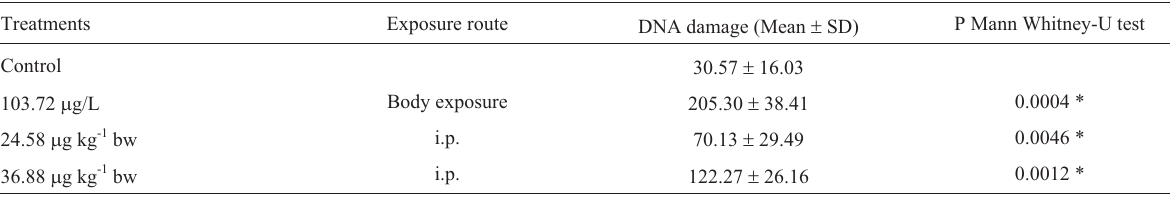
Table 2 - Means (SD) of DNA damage index obtained from comet assay from peripheral erythrocytes of Astyanax bimaculatus after treatment with ex- tracts with different concentration, considering two exposure routes. Treatments